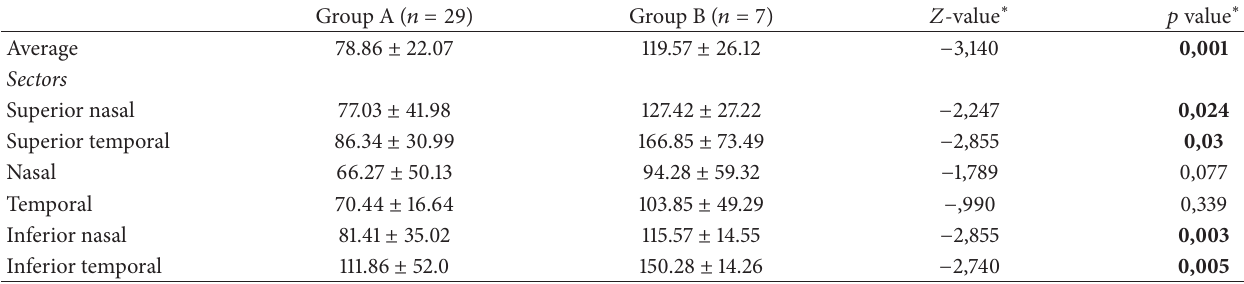
Table 2: RNFL thickness measurements at the time of peripapillary retinoschisis.